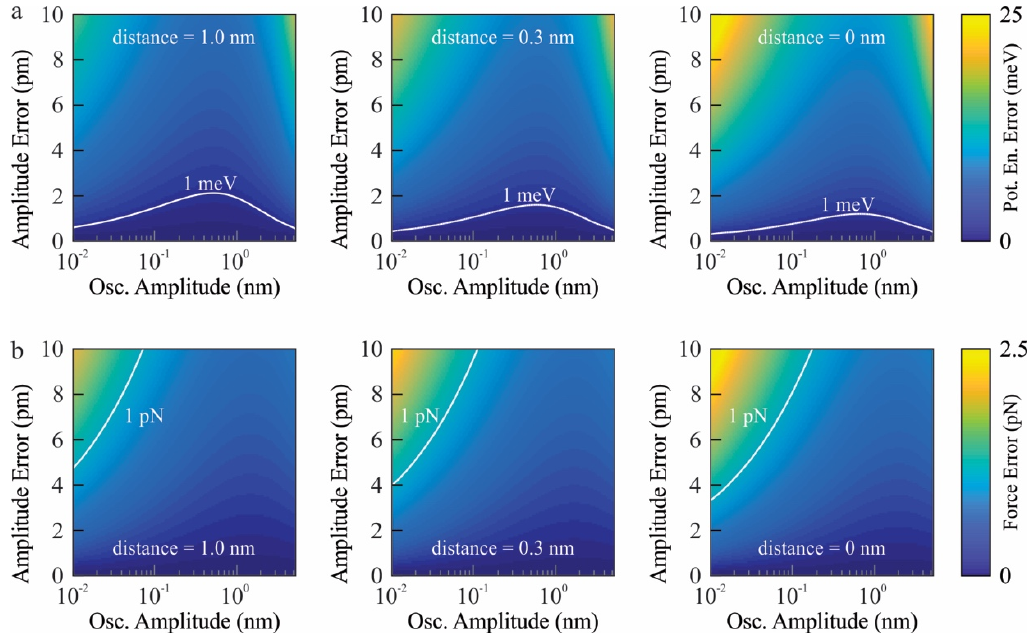
Figure 3. The effect of amplitude dependence of the resonance frequency on recovered tip-sample interaction potential ( a ) and force ( b ) of tip-sample distance and amplitude error. ( a ) The error of recovered tip-sample interaction potential increases with decreasing tip-sample separation. To keep the error less than one milli-electron volt and one pico-Newton (white contour in ( a , b )), the amplitude error should be less than one picometer. If the amplitude error is not constraint to sub-picometer range, the frequency shift due to the amplitude dependence of the resonance frequency should be corrected. By this way, the intrinsic contribution of frequency shift due to tip-sample interaction can be calculated and error in the reconstructed tip-sample interaction potential and force can be eliminated. The reference point for the distance, i.e., distance = 0, is defined as the potential energy minimum of the model tip-sample interaction (see SM for details).